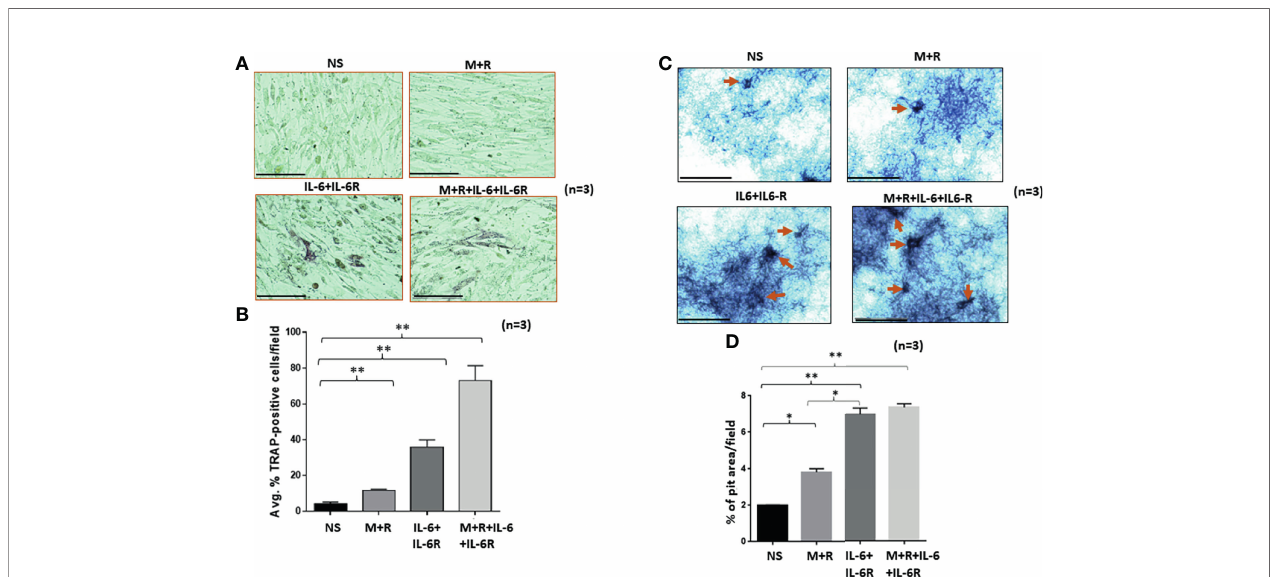
FIGURE 1 | Human RASFs in the presence of IL-6/IL-6R exhibit enhanced TRAP-positive staining and transform to an invasive phenotype. (A) RASFs grown with M-CSF (2 ng/ml)+ RANKL (10 ng/ml) (M+R) alone or with IL-6 and IL-6R (100 ng/ml each) for 12 days show an increased number of TRAP-positive RASFs compared with M-CSF/RANKL-differentiated and nonstimulated (NS) cell population. (B) IL-6+IL-6R treatment found to be almost 40% TRAP-positive cells which is more synergetic in combination with MCSF+RANKL where 70% of RASF cells are TRAP positive. (C) RASFs grown on calcium phosphate plates with M-CSF+ANKL alone or with IL-6+IL-6R for 12 days shows the increased pit formation on calcium phosphate-coated plates. (D) An average of three independent fi eld quanti fi cations of pits formed by RASFs from n = 3 patient donor samples reveal a threefold increase in the number of pits formed in calcium phosphate-coated plates when RASFs were stimulated with IL-6/IL-6R alone or in combination with M-CSF/RANKL as compared with nonstimulated RASFs, presented as mean ± SEM. * p < 0.05; ** p < 0.01. Bar scale for images acquired is 150